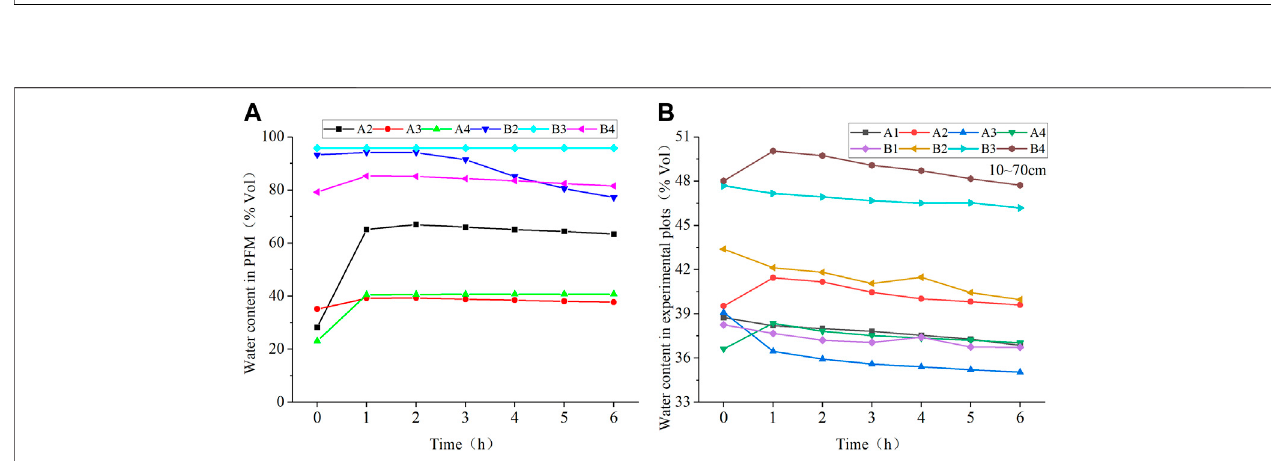
FIGURE 11 | Redistributions of soil and PFM water content in experimental plots from 1 to 6 h after rainfall (The letters (A) and (B) in the top left corner represent PFM and experimental plots, respectively.